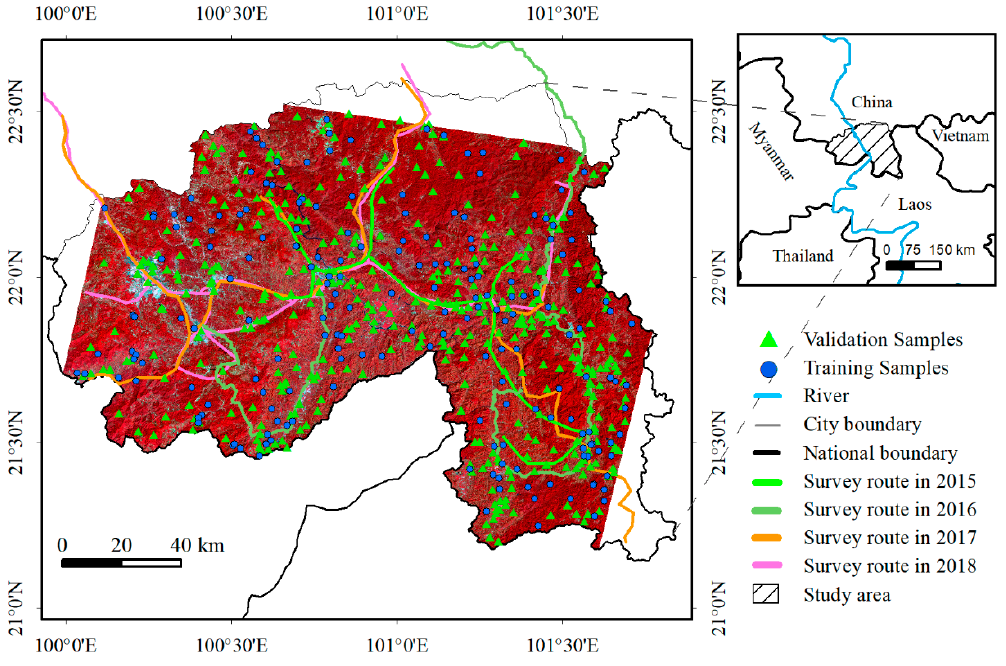
Figure 1. Location of the study area and field survey samples and routes. Table 2. Classification system and